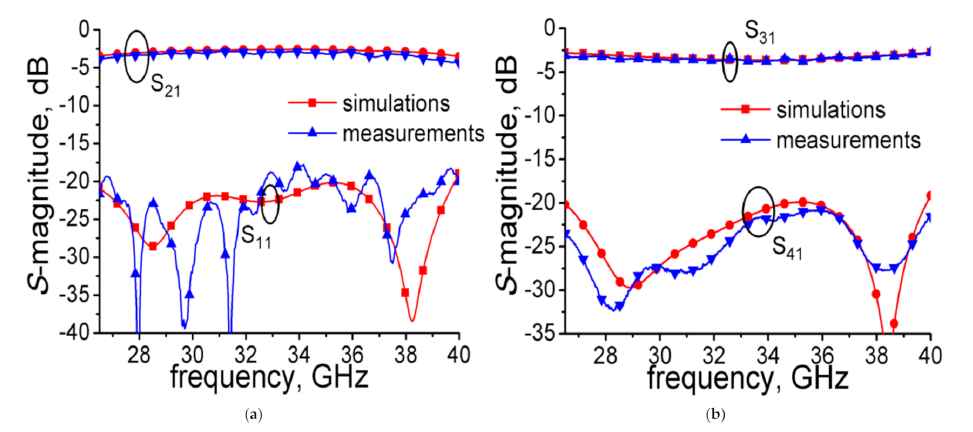
Figure 7. Simulated and measured results of the sample coupler: ( a ) S 11 and S 21 and ( b ) S 31 and S 41